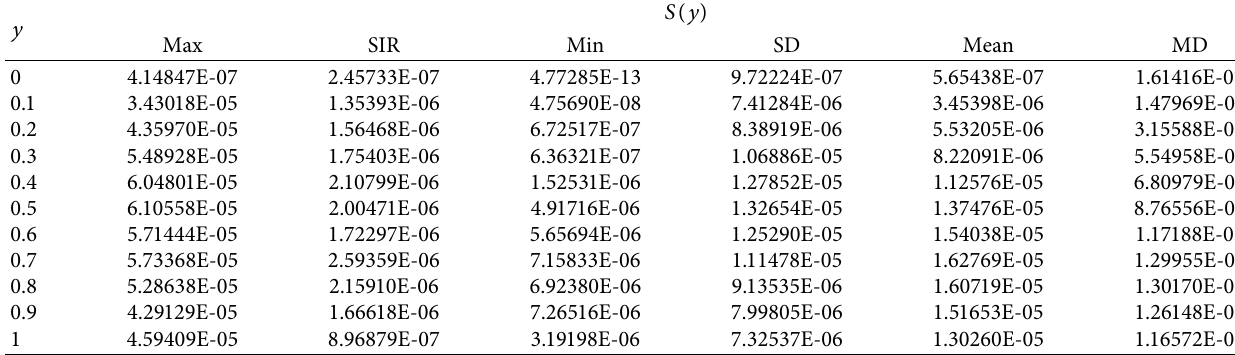
Table 2: Statistical performances for the class S ( y ) of the model.